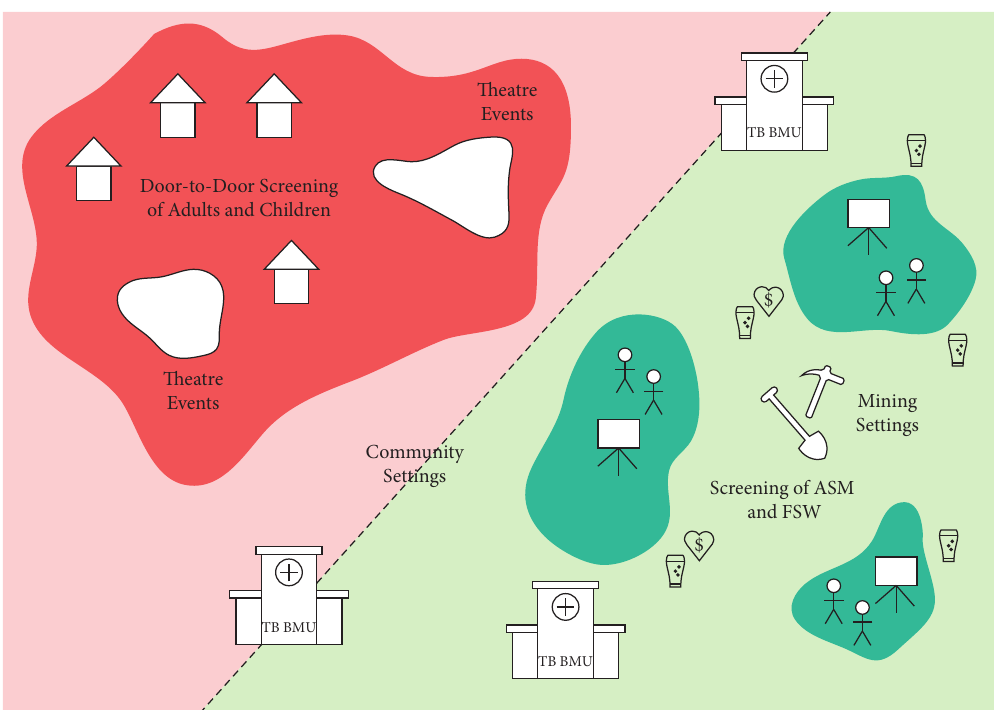
Figure 2: Types of active case-finding interventions conducted in Shinyanga and Geita regions,